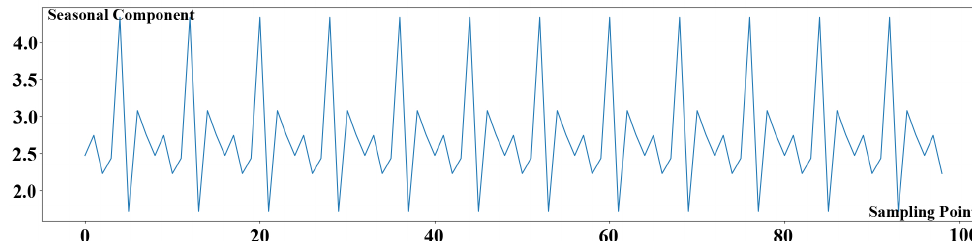
Figure 3. Seasonal components